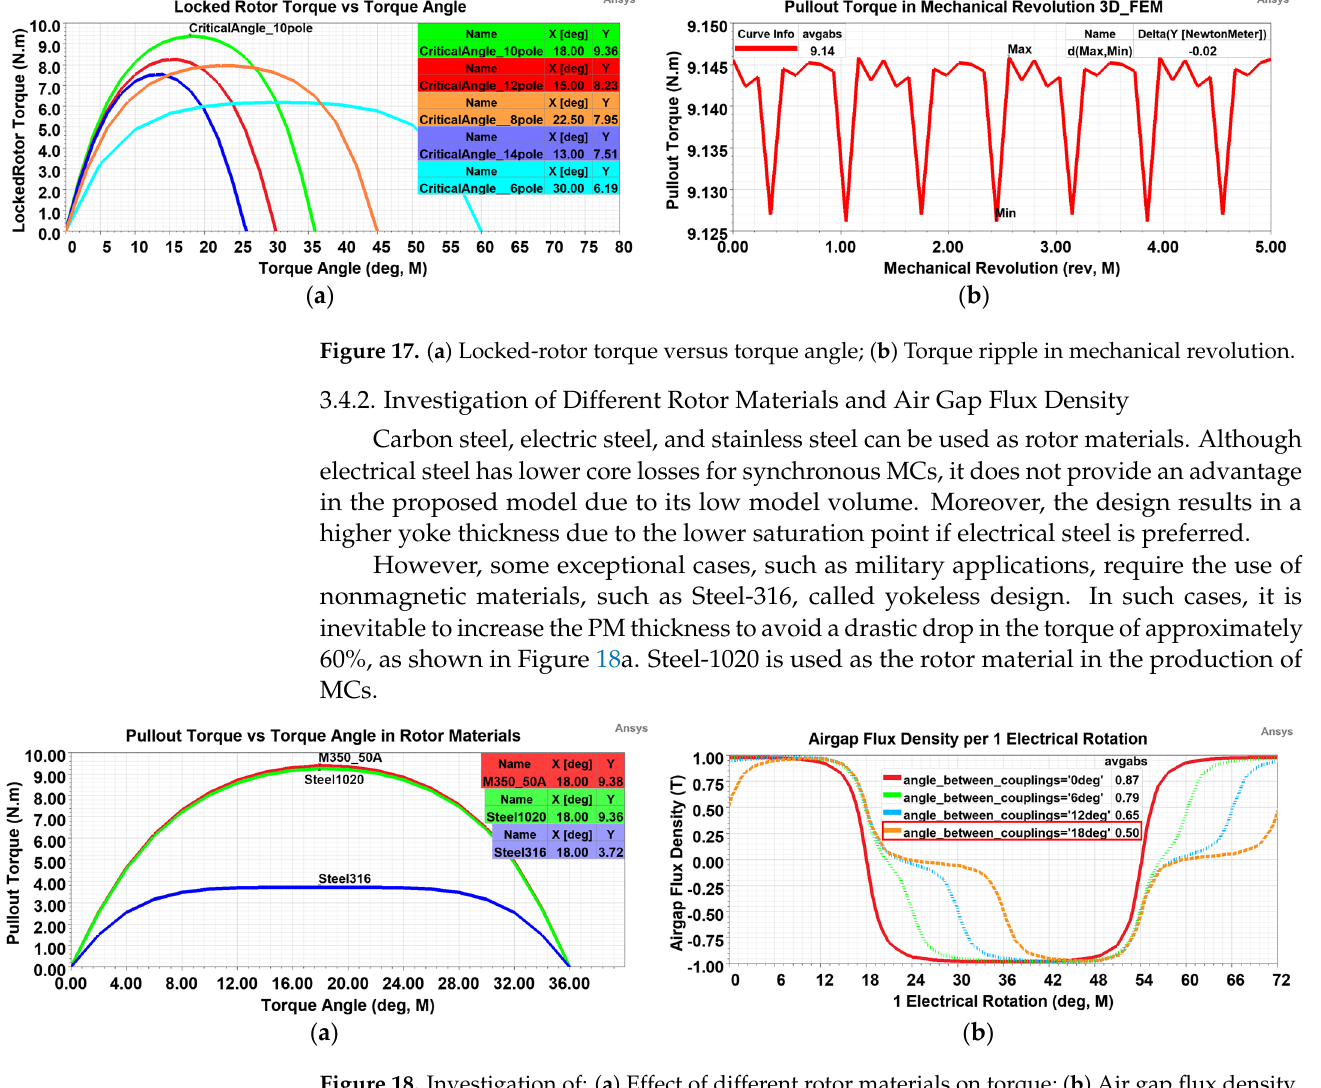
Figure 19. ( a ) Pullout torque depending on misalignment length; ( b ) Exhibition of misalignment. 3.4.4. Magnetic Coupler Efficiency and Induced Eddy-Current Losses on PMs Magnetic coupler losses are composed of rotor core losses, induced eddy-current losses on PMs, and mechanical losses. The mechanical losses, estimated at 3.5% of the output power, are thus calculated as 0.00051 W/(rad/sec) 2 . On the other hand, vibration due to the natural operation of the PE, load disturbances due to different UAV operating zones, and torque fluctuations during load changes cause the torque angle to change con- tinuously. As a result, high eddy-current losses are induced on the PMs, which increase the temperature of the PMs and reduce the transmitted torque by reducing their residual flux density, and their impact on the system should be investigated. The proposed MC design is realised in light of all these effects and the design requirements are provided. As seen in Figure 20a, the eddy-current losses are simulated as 237 W. The efficiency of the MC is 94.3% at the maximum speed of 6500 rpm and 95% at the minimum speed of 2500 rpm, as shown in Figure 20b at the critical angle. However, to measure the efficiency on the test bench, a second transmitter is required to measure the input power in addition to the torque/speed transmitter measuring the output power. Due to the difficulty in the setup, the efficiency cannot be measured on the test bench. However, using the proposed correction coefficient, the actual efficiency can be estimated from the numerical efficiency graph.